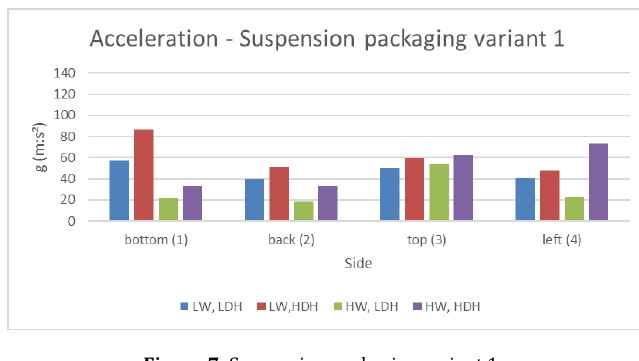
Figure 7: Suspension packaging variant 1